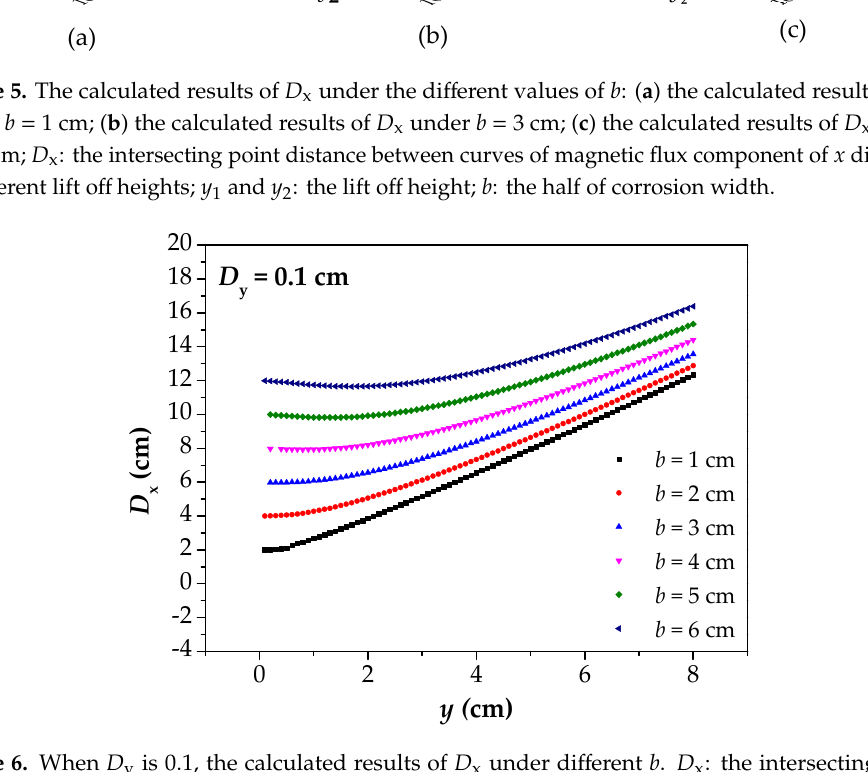
b (cm) Figure 7. The relationship between D x and b under different y . D x : The intersecting point distance between curves of magnetic flux component of x direction at different lift off heights; b : the half of corrosion width; Y : the lift off height. The relationship between D x and h were analyzed for b = 4 cm, and h = 1 cm to 6 cm, and partial results are shown in Figure 8. All of the parameters of calculation are shown in Table B4. Figure 8 reflects the relationship between D x with different lift off heights. It can be seen from the image that for the different h , the overall trend of D x is basically the same. As the same with the Figure 5, the whole curves show a same trend of divergence with the increase of y 1 and y 2 , but they all converge to the same value with the decrease of y 1 and y 2 . In the same processing method, the results of two- dimensional data are shown in Figure 9.